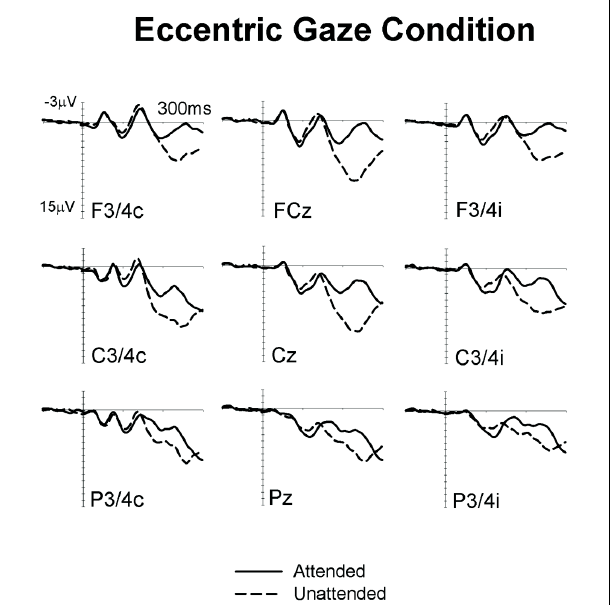
FIGURE 1 | Grand-averaged somatosensory ERPs elicited in the Eccentric gaze condition at midline electrodes, and at sites contralateral (C) and ipsilateral (I) to the stimulated hand, by tactile non-target stimuli presented to the attended hand (solid lines) and to the unattended hand (dashed lines) in the 300 ms following stimulus onset (relative to a 100 ms pre-stimulus baseline).